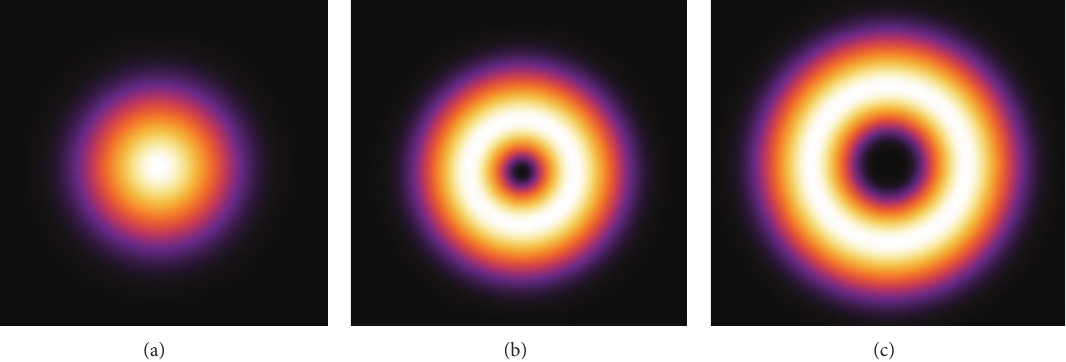
Figure 7: The intensity distributions of Laguerre-Gaussian beams with different OAM states: (a) ℓ = 0 , (b) ℓ = ±1 , and (c) ℓ = ±2 (from Wikipedia).